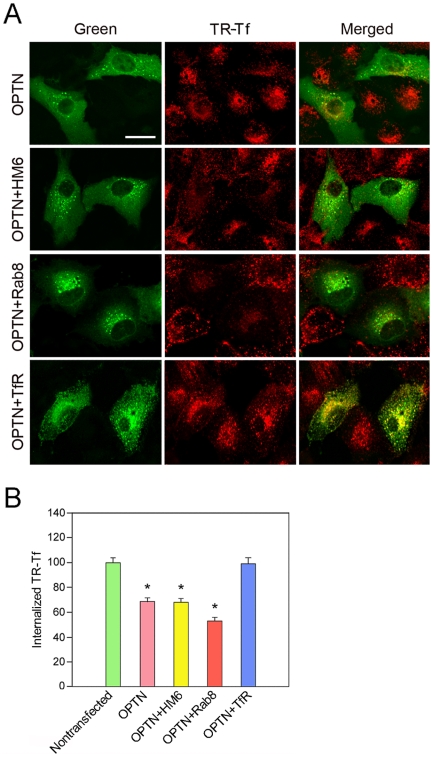
Rescue of Tf uptake by co-transfection with TfR but not with myosin VI and Rab8 constructs in RPE cells.(A) Fluorescent images of RPE cells. The cells transfected with pOPTNWT-GFP (OPTN) alone, or co-transfected with pOPTNWT-GFP and pMyoVI-EGFP (OPTN + HM6), pRab8Q67L-EGFP (OPTN + Rab8), or pTfR-EGFP (OPTN + TfR) were incubated with Texas Red-Tf (TR-Tf) for 15 min. The single or co-transfected cells are in green and the internalized TR-Tf is seen in red. The yellow staining in perinuclear regions (bottom panel, merged) indicated interaction and colocalization between the expressed TfR-GFP and the internalized TR-Tf. Scale bar, 20 µm. (B) Quantification of TR-Tf uptake in nontransfected and single- or co-transfected RPE cells. Note that co-transfection with myosin VI and Rab8 constructs had little effect, while co-expression of TfR restored the Tf uptake to the nontransfected control level in OPTNWT-GFP-expressing cells. Data are expressed as mean ± SD. Experiments are repeated at least three times, yielding similar results. *, P<0.001 compared to nontransfected cells.